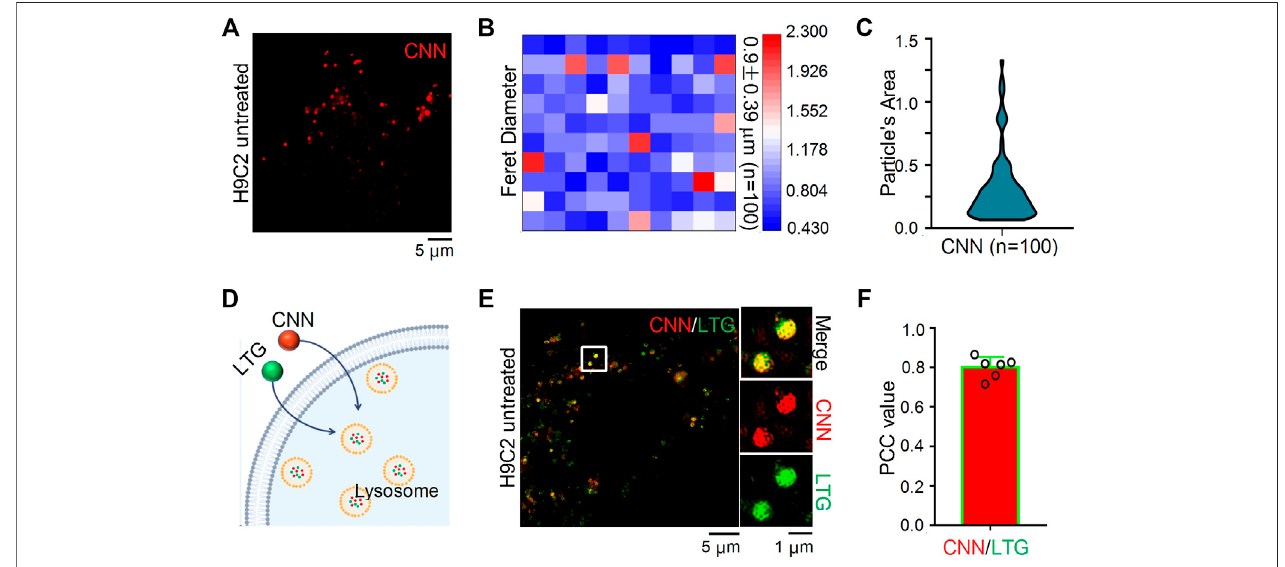
FIGURE 2 | SIM images and Co-localization of CNN in H9C2 cells. (A) SIM image of H9C2 cells stained with CNN (0.5 μ M, λ ex = 405 nm) for 1 h. (B) Particle ’ s diameteroftheCNNpuncta. n =100. (C) Particle ’ sareaoftheCNNinlivingcell. n =100. (D) SchematicdiagramofLTG(100 nM, λ ex =488 nm)andCNNjointlylabeling lysosomes. (E) MergedSIMimagesofH9C2cellsstainedwithCNNandLTG.Whitecirclenotestheenlargedpart. (F) Quantitativeanalysisofthecolocalizationbetween CNN and LTG.